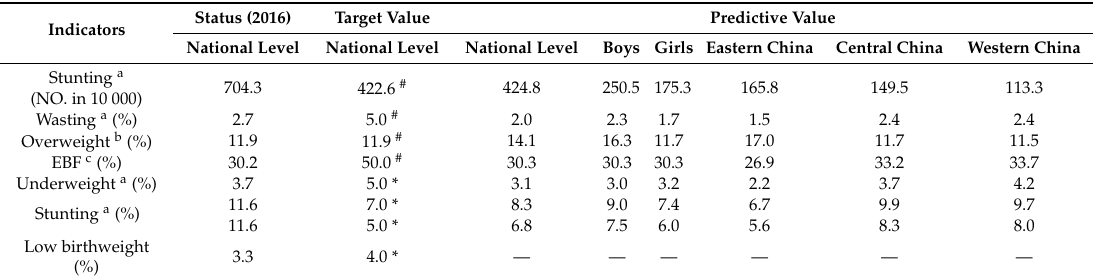
Table 2. Gap analysis results for nutrition indicators in